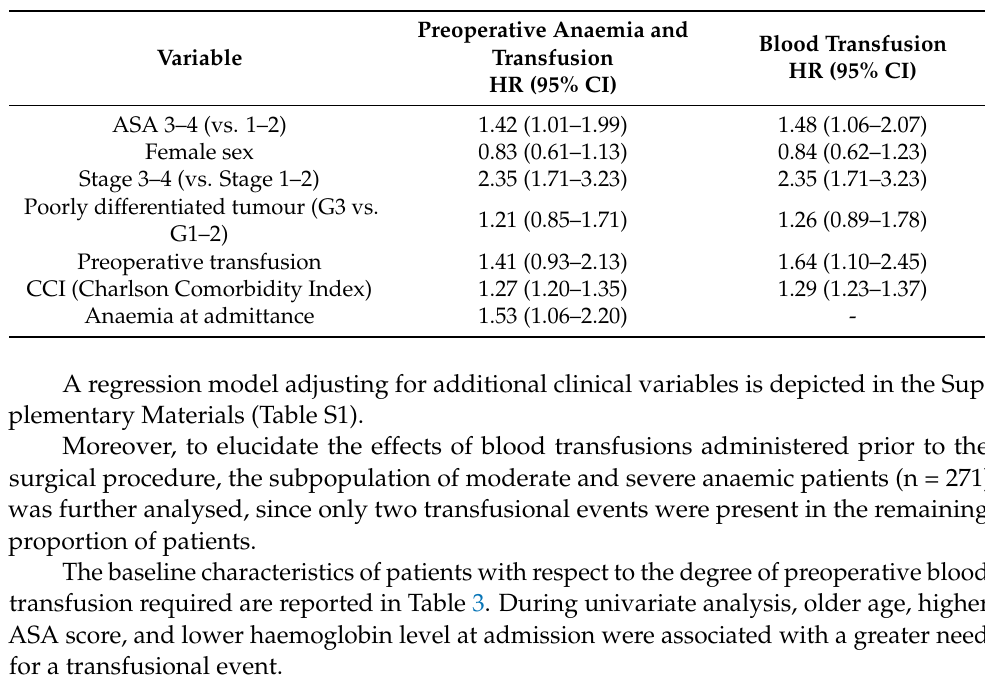
Table 2. Multivariate analysis for overall survival in the study population.